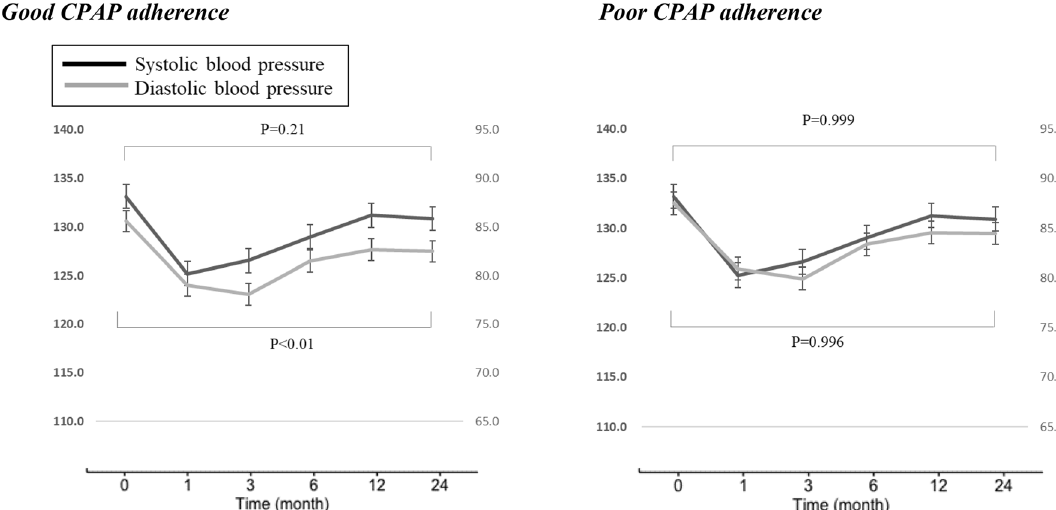
Figure 2. Correlation between changes in systolic and diastolic blood pressure and adherence of continuous positive airway pressure. Thick line (left axis), systolic blood pressure (mmHg); Thin line (right axis), diastolic blood pressure (mmHg); Good CPAP adherence, time using CPAP more than 4 h ≥ 70% of the 30 days prior to all follow-up points; Poor CPAP adherence, time using CPAP more than 4 h ≤ 70% of the 30 days prior to all follow-up points. Time, month of CPAP treatment. Upper P values are related to systolic blood pressure and lower p values are related to diastolic blood pressure. Model has adjusted for age and body